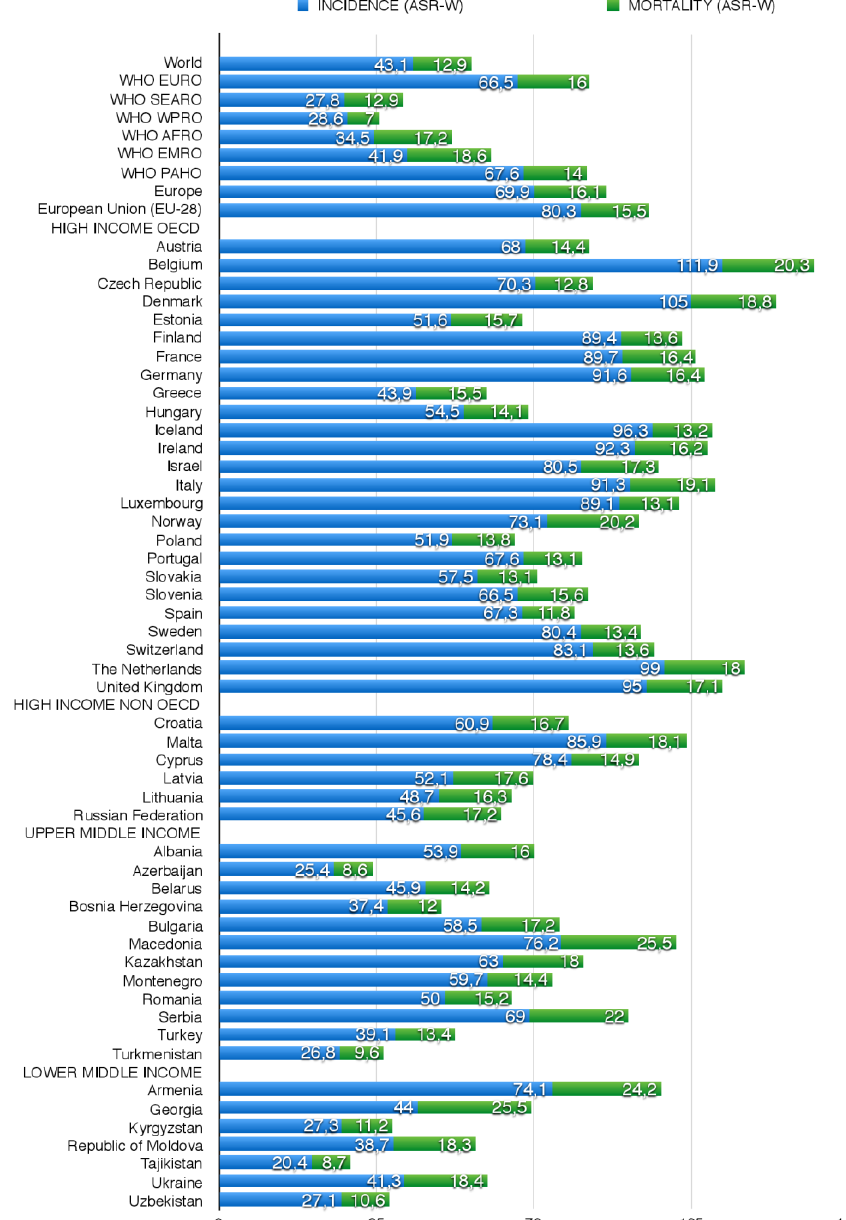
Figure 1. Breast Cancer Incidence and Mortality data and their age standardized rates per 100,000 population (ASR-W), in WHO European Region Countries and in the World, according to GLOBOCAN 2012 (Andorra, Monaco and San Marino not reported).